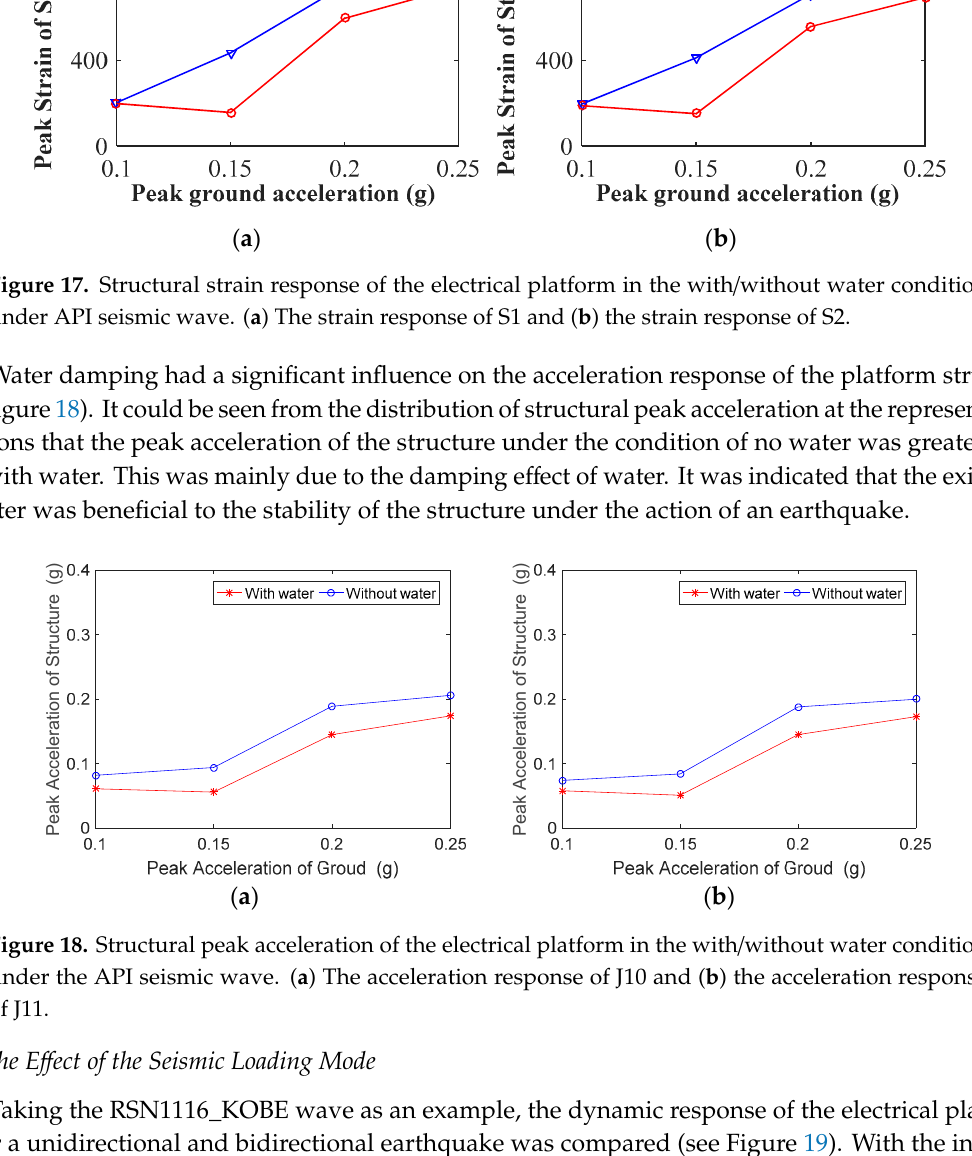
Figure 18. Structural peak acceleration of the electrical platform in the with/without water condition under the API seismic wave. ( a ) The acceleration response of J10 and ( b ) the acceleration response of J11.